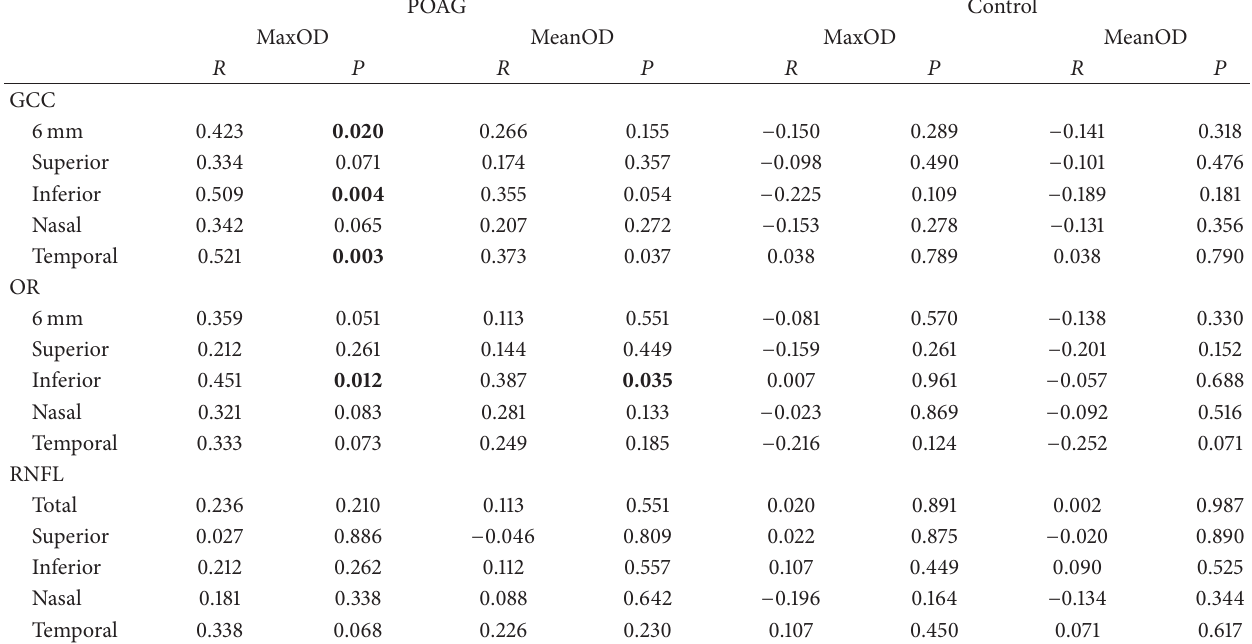
Table 4: Pearson correlations between MPOD and retinal thickness in the POAG and control groups.